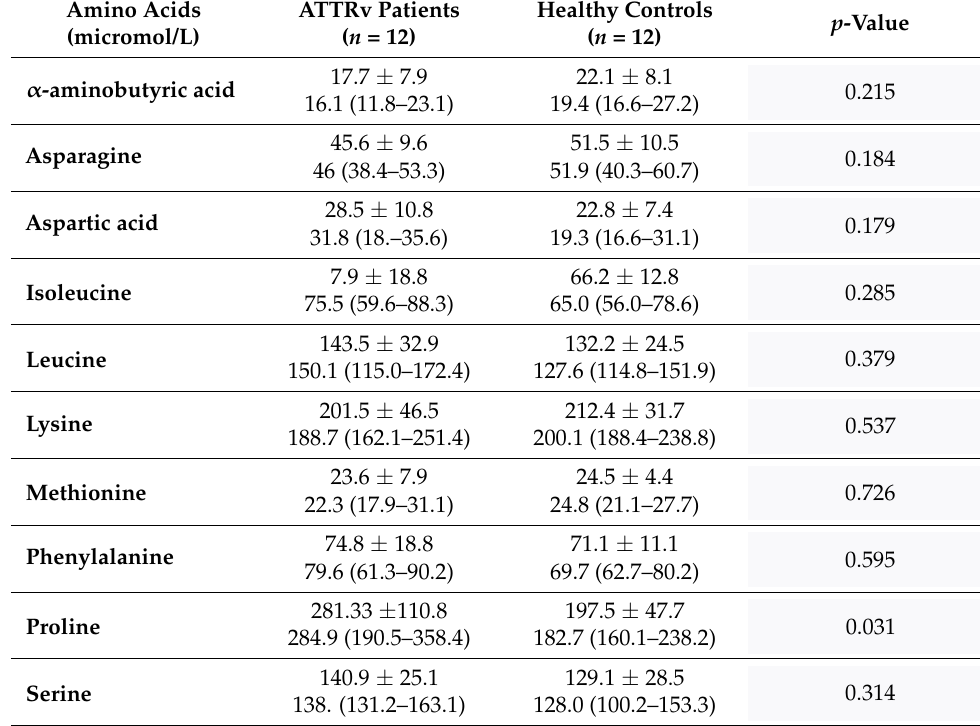
Table 3. Comparison of amino acids levels in ATTRv patients and in healthy controls, expressed as mean ± standard deviation (SD) and median and interquartile range (IQR). Bold values denote statistical significance at the p < 0.002 considering Bonferroni’s correction for multiple testing.